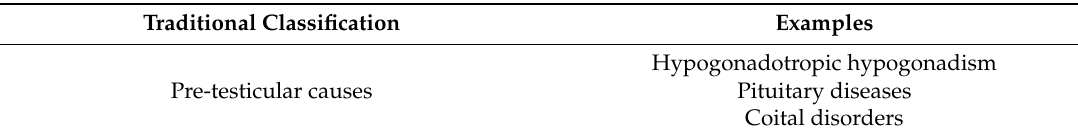
Table 1. Comparison between the traditional and newly proposed, clinically based classification of male infertility